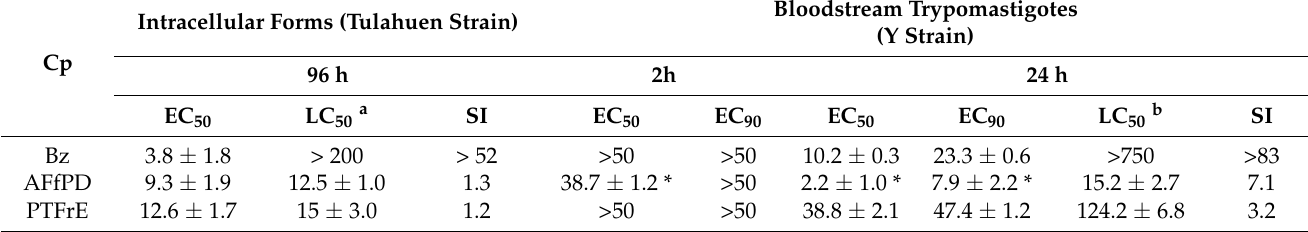
Table 2. Activity (50% effective concentration, µ g/mL) of the natural products against intracellular and bloodstream forms of T. cruzi (EC 50 ), mammalian cell’s toxicity (L929 cell lines and cardiac cell cultures-LC 50 ) and respective Selectivity Indexes (SI).